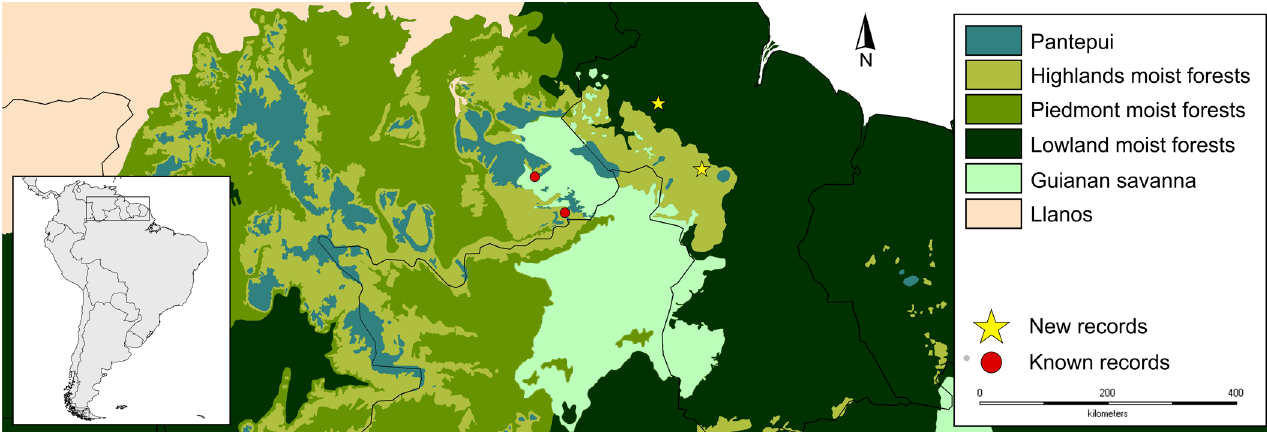
Known geographic distribution and associated ecoregions of